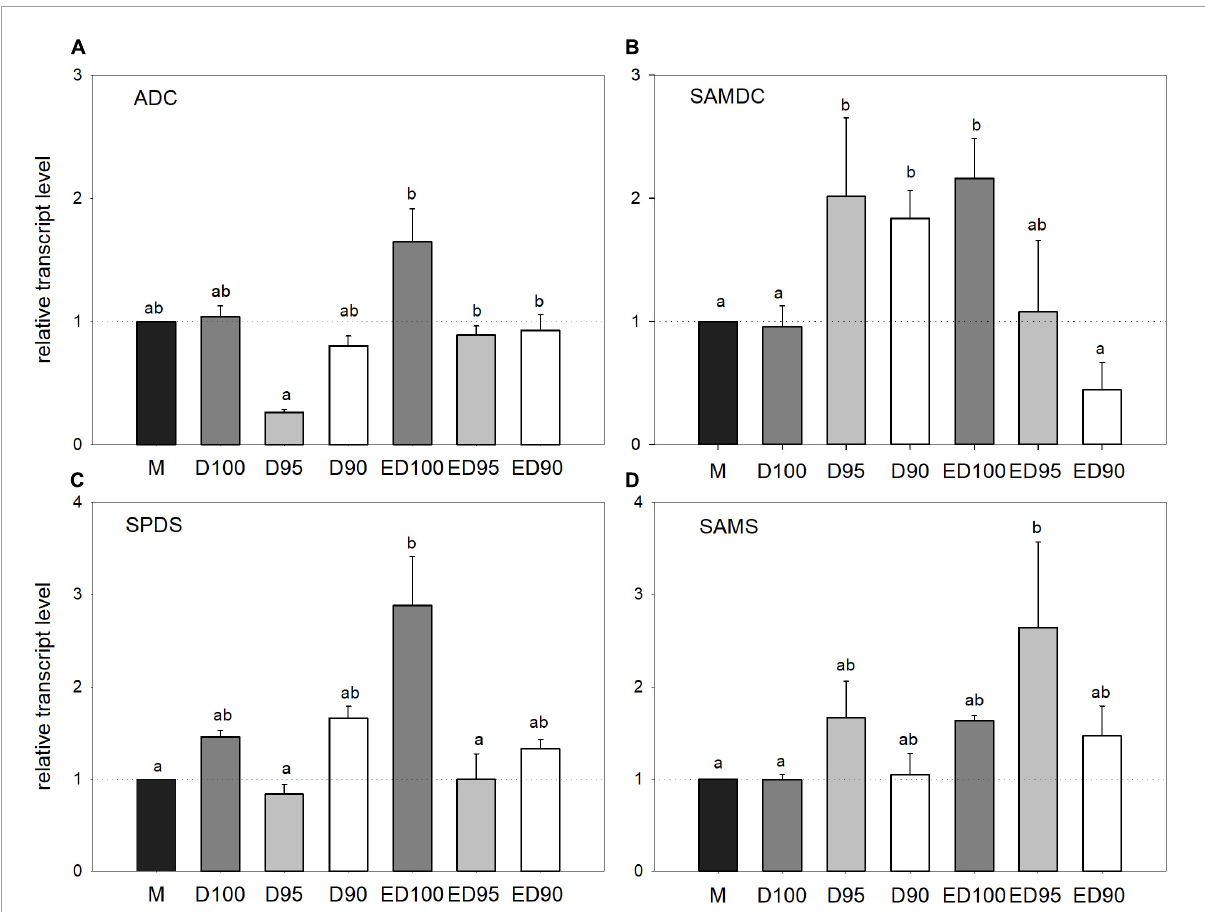
FIGURE9 Relative transcript levels of polyamine biosynthetic enzyme genes ADC (A) , SAMDC (B) , SPDS (C) , and SAMS (D) in mature embryos (M), control embryos at half (D100), and at the end (ED100) of treatment with 100% relative humidity, and embryos exposed to 95 and 90% relative humidity during the first half of desiccation (D95 and D90) and subsequently transferred to 100% relative humidity (ED95 and ED90). Transcript levels are compared relative to expression levels in mature embryos (value1). Values are expressed as means ± standard deviations ( n = 9). Different letters indicate statistically significant difference at p ≤ 0.05. ADC, arginine decarboxylase; SAMDC, S-adenosylmethionine decarboxylase; SPDS, spermidine synthase; and SAMS, S-adenosylmethionine